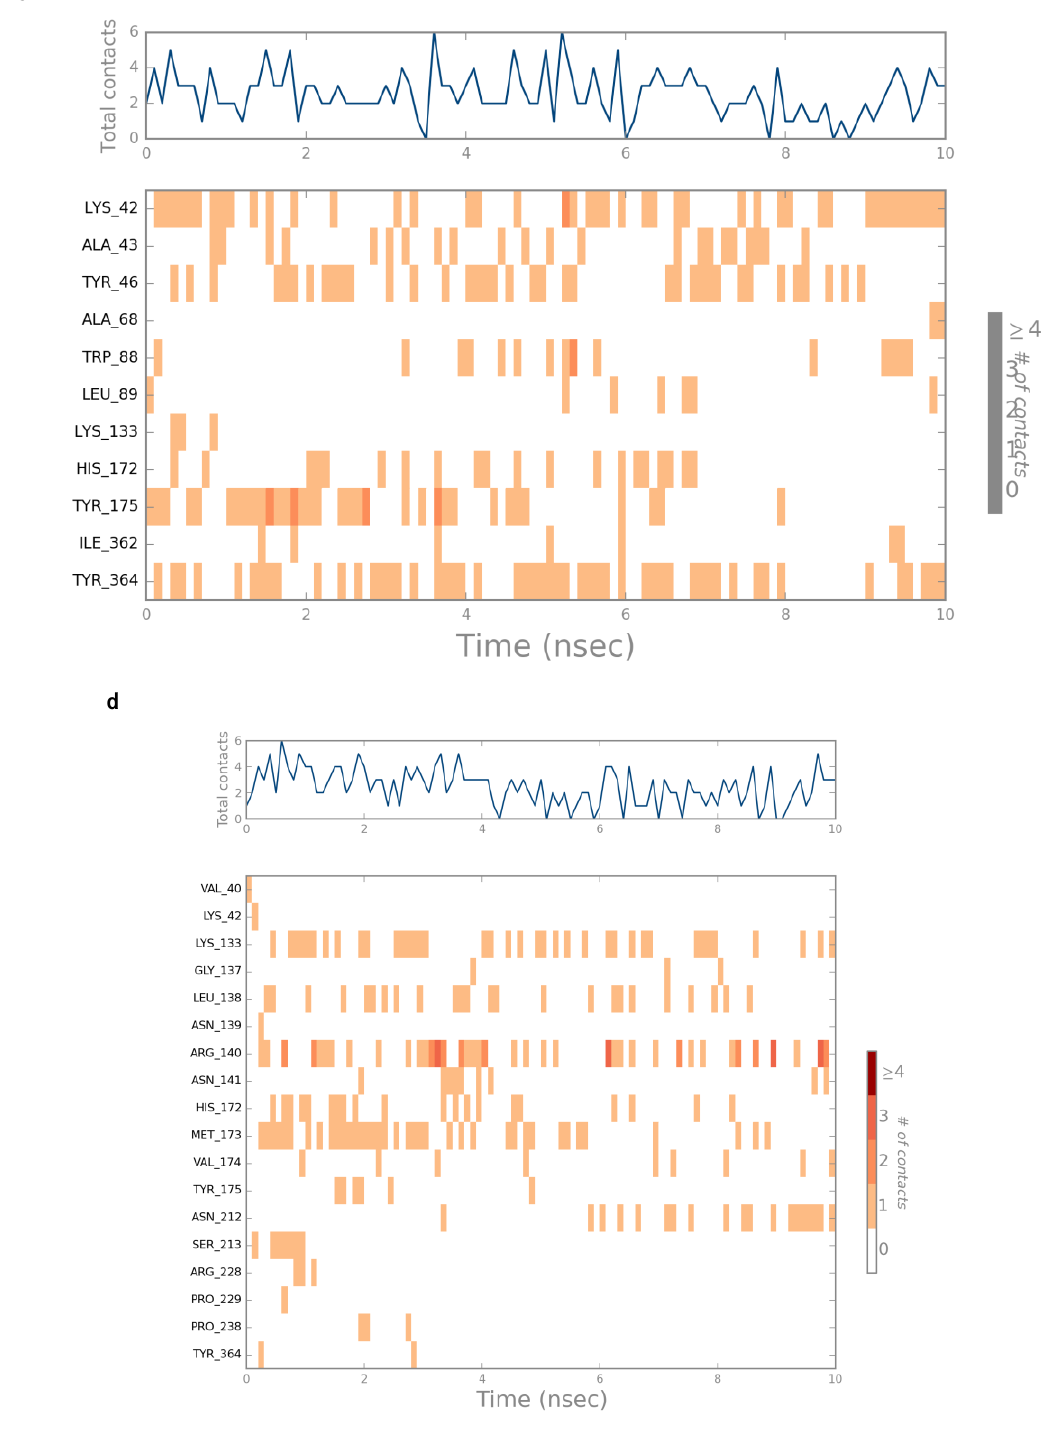
Figure S8. A timeline representation of the interactions and contacts of compounds (a) 10 (b) 19 (c) 21 and (d) 25 within the catalytic pocket of M. tuberculosis AlaR enzyme (PDB ID: 1XFC) during MD